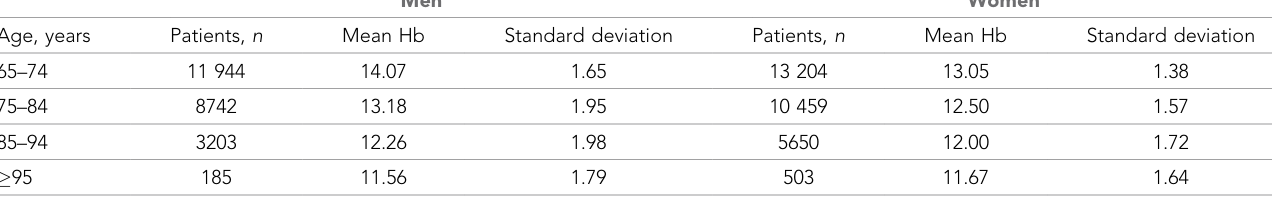
Table 2. Mean haemoglobin (Hb) in men and women.